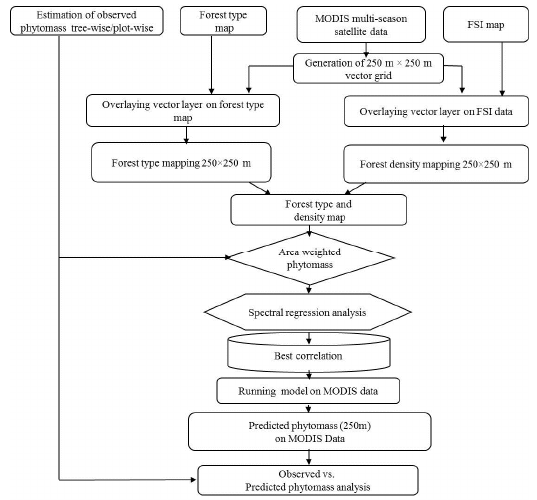
Figure 4. Steps followed spectral modeling of phytomass